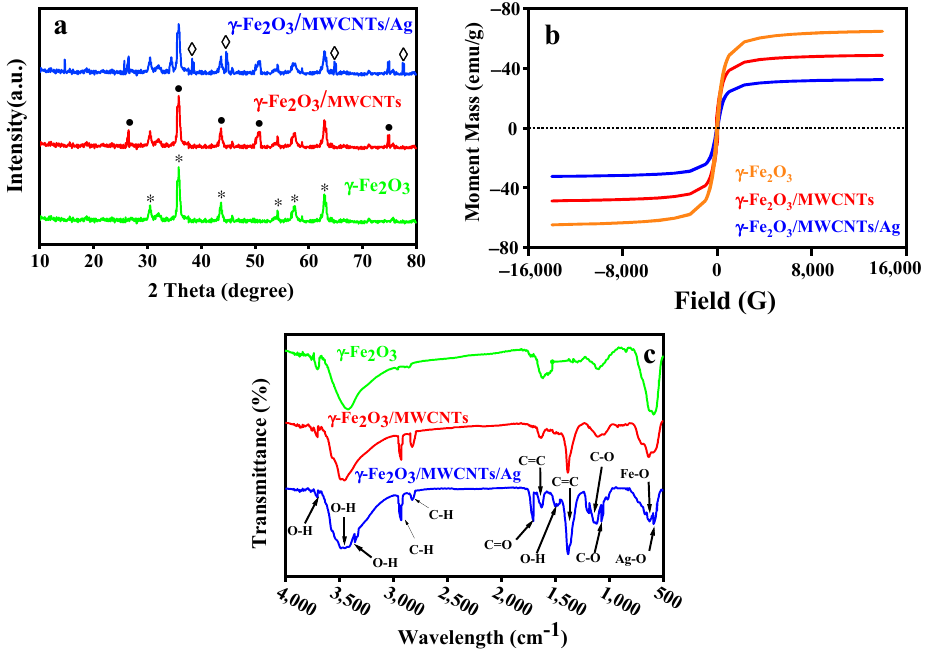
Figure 4. Crystallinity ( a ), magnetic ( b ), and chemical ( c ) properties of the γ -Fe 2 O 3 /MWCNT/Ag NC particles compared to those of γ -Fe 2 O 3 NP and γ -Fe 2 O 3 /MWCNT. The crystallite size of γ -Fe 2 O 3 and Ag NPs was calculated via Debye-Scherrer’s Equa- tion (10) [41]: